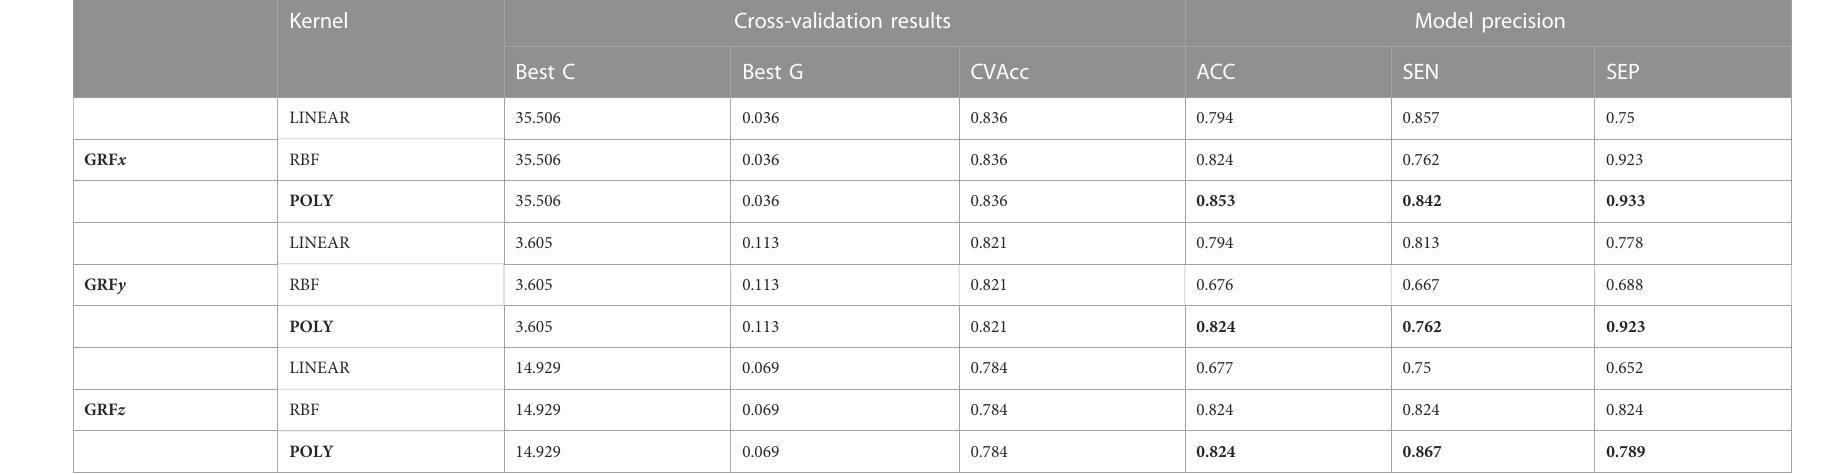
TABLE2Comparison ofresultsfrom thedifferentSVMclassi fi cationalgorithmsdesigned forSVMmodels ofGRFx, GRFy,andGRFz. Note:Thebestkerneltypeishighlighted inbold.GRFx:medial-lateral direction ofGRF,GRFy: anterior-posterior direction of GRF, GRFz: vertical direction of